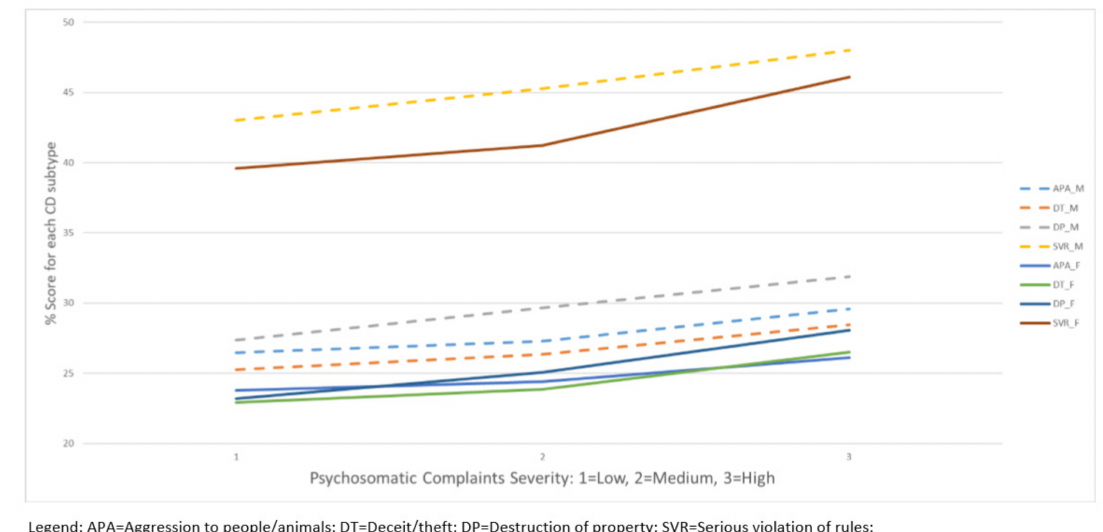
Figure 2. Behavioral Disorders scores in relation to levels of psychosomatic complaints in Sweden adolescents aged 15–18 years old.